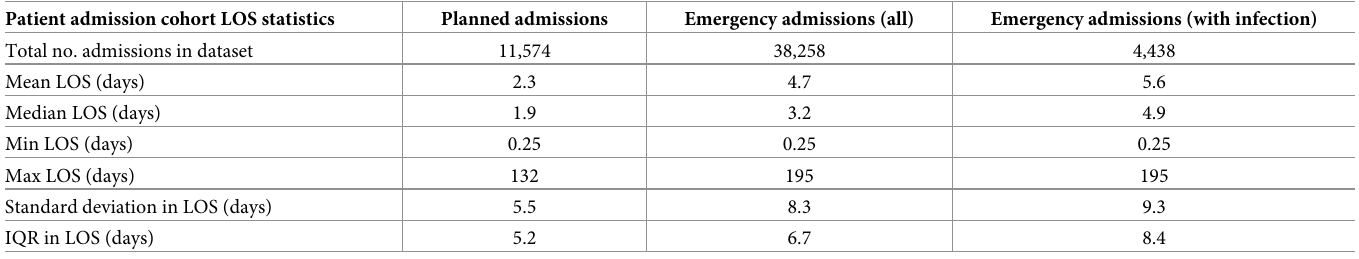
Table 1. Statistical analysis of data